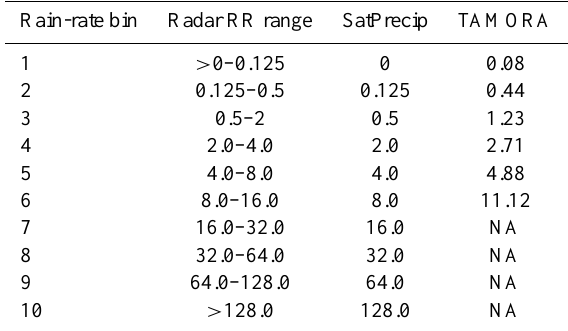
Table 1. Radar rain-rate (RR) bins used for SatPrecip and TA- MORA calibration, and corresponding values of SatPrecip and TA- MORA output rain-rate (all mm/hr). Only RR bins 1–4 are used by SatPrecip over Europe, and only RR bins 1–6 are used by TA-